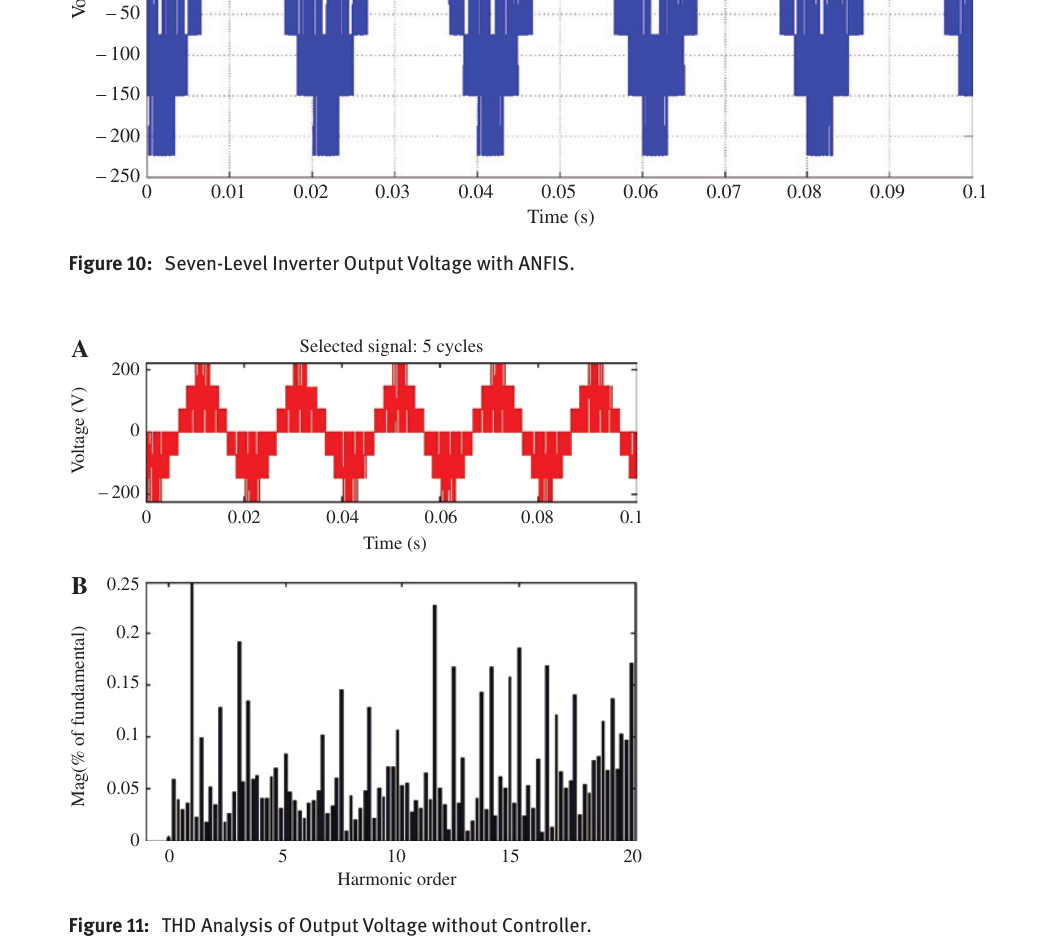
Figure 11: THD Analysis of Output Voltage without Controller. (A) Selected five cycles of voltage. (B)